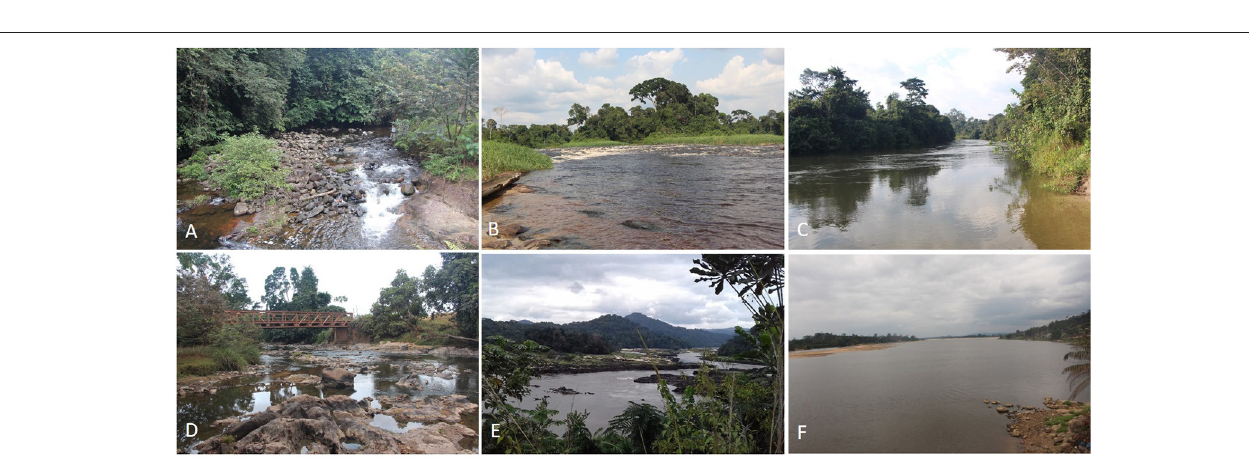
FIGURE 2 | Photos of (A) Mbei river tributary 1, (B) Ivindo river at Loaloa (a Northern basin), (C) Lékoni river at Lakeni (Plateaux Batéké basin), (D) Lopé river at Lopé (a Southern basin), (E) Ogooué River at Ndjolé, and (F) Ogooué River at